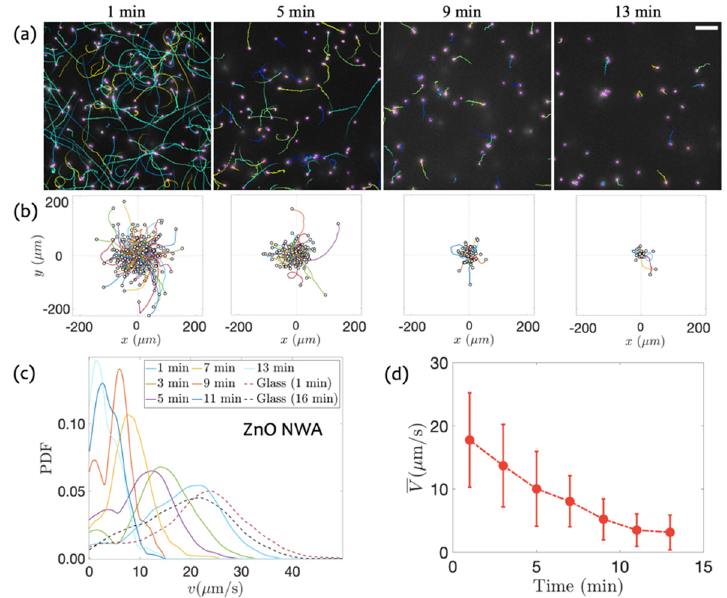
Figure 2. Swimming trajectories and motility variation on ZnO NWA. ( a ) Bacteria trajectory varying with time from 1 min to 13 min. Each trajectory is observed with a duration longer than 2 s at the focal plane. ( b ) All the trajectories are overlapped into a centered start point. ( c , d ) Probability density function and mean swimming speed, respectively. The scale bar represents 30 μm .